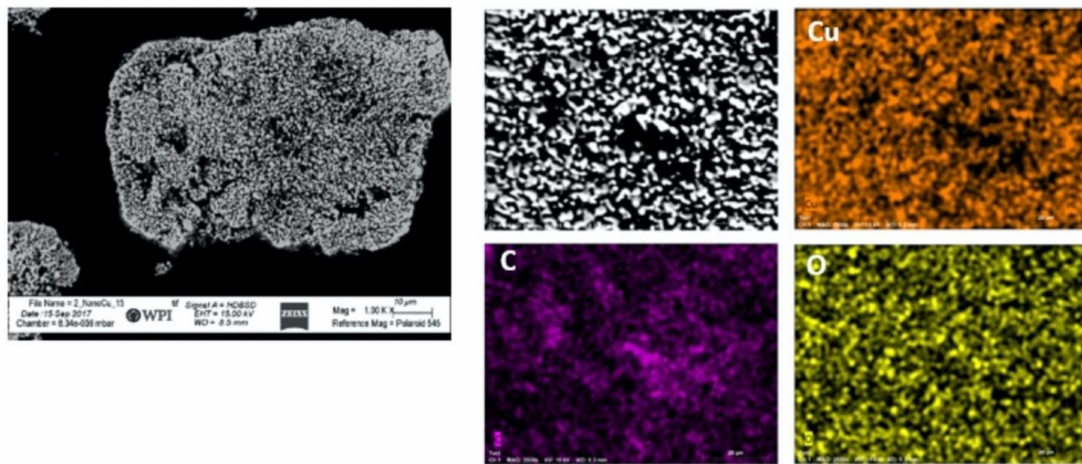
Figure 7. EDS analysis of spray-dried Cu powder. O and Cu are of interest whereas the C content follows from the chemical nature of the mounting